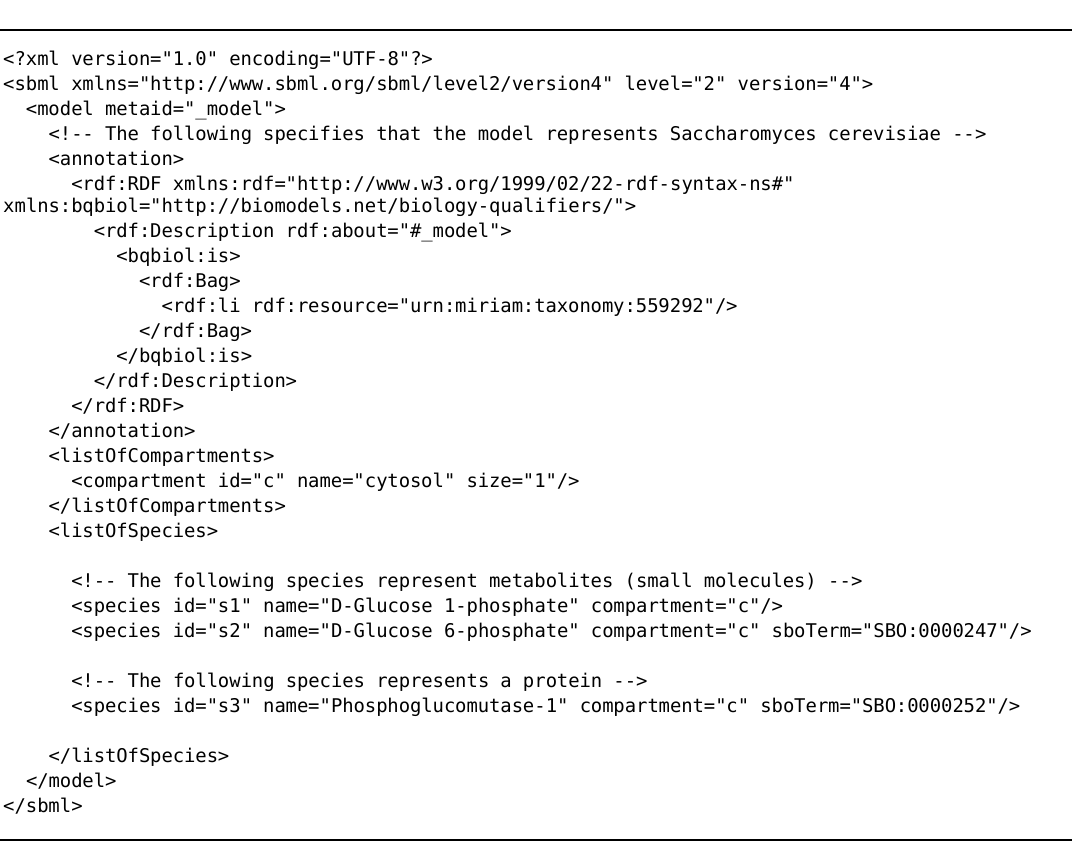
Figure 3: Simple SBML model indicating how metabolites and enzymes are distinguished in the Annotate module by use of sboTerm attributes on the species elements. By default, all species are considered to be metabolic (small molecules) but this can be made explicit through use of the SBO term SBO:0000247 ( simple chemical ). Enzymes are specified with the SBO term SBO:0000252 ( polypeptide sequence ). Annotating the model element with an NCBI Taxonomy term (in this case, 559292 , representing Saccharomyces cerevisiae ) limits the subsequent UniProt search to proteins belonging to the specified